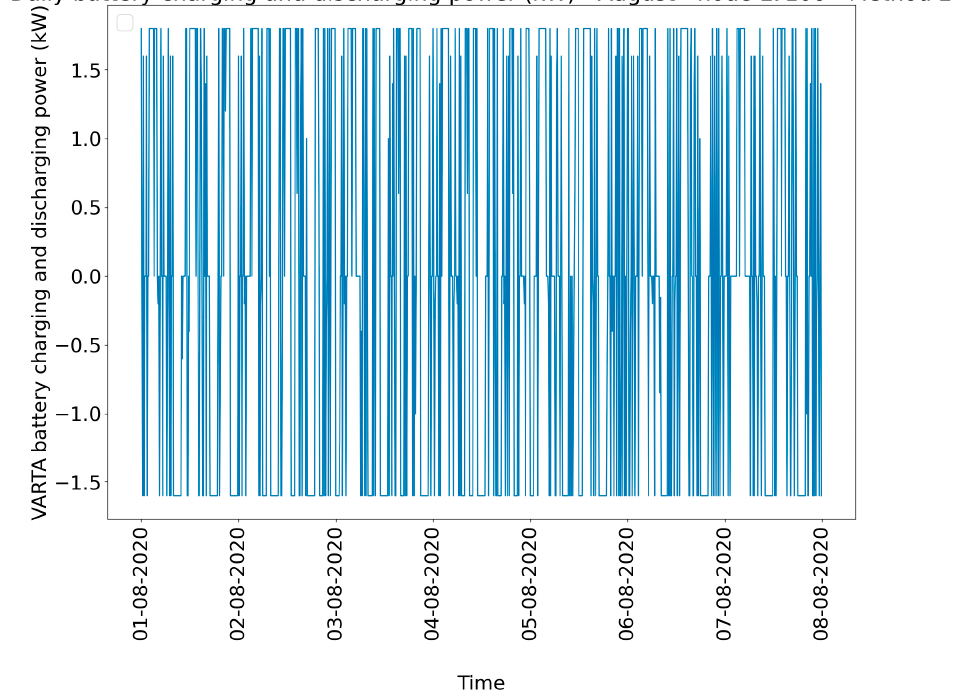
Figure A8. VARTA battery charging and discharging curve—August—Method 2. Table A1. EV charging power in January.